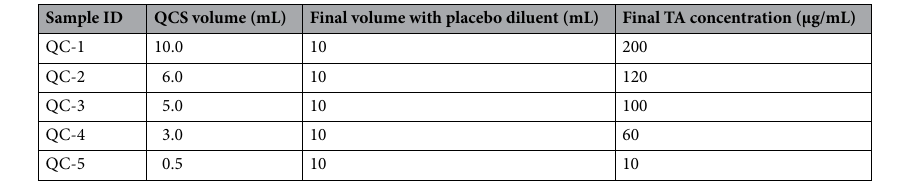
Table 3. Preparation of QC samples.